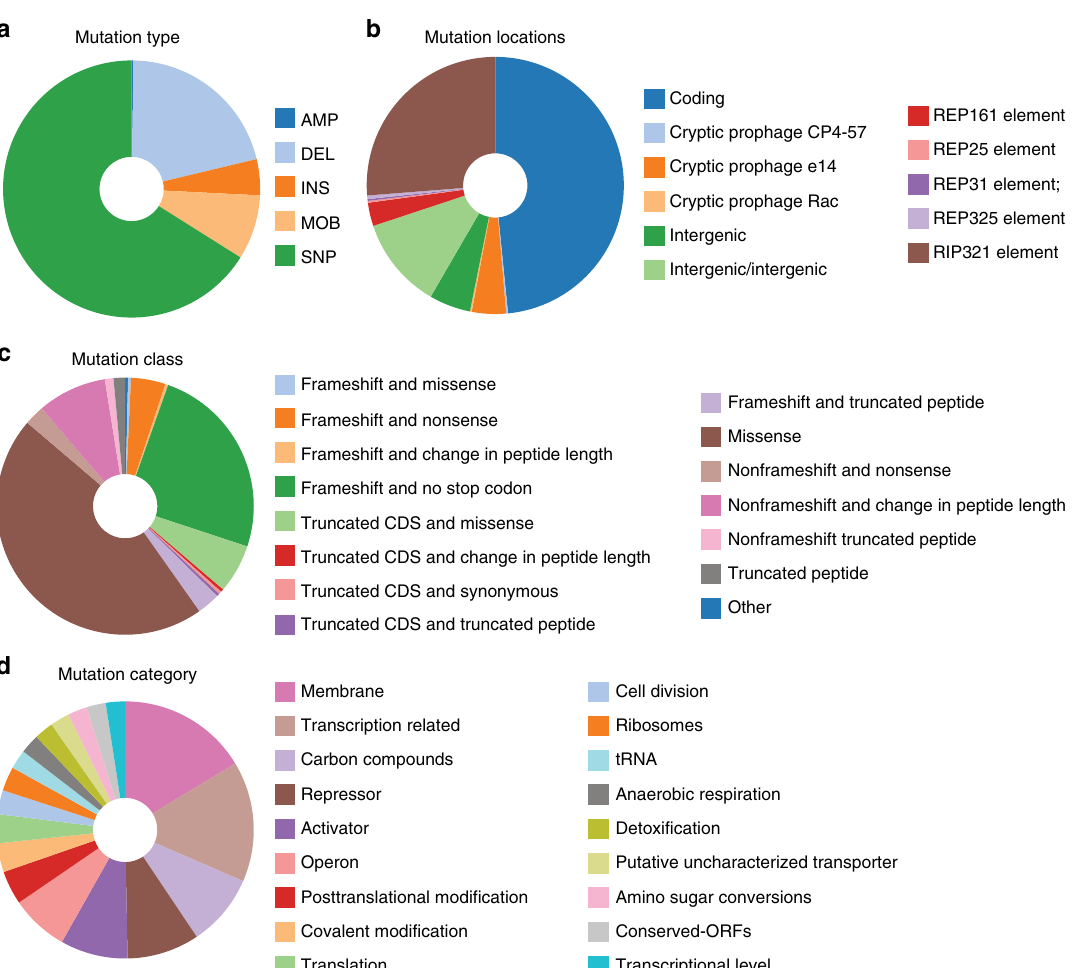
Fig. 6 Overview of mutation statistics. See Supplementary Data 6 for detailed statistics of each category and categories not shown. a The type of mutation. Mutations include ampli fi cation (AMP), deletion (DEL), insertions (INS), mobile element aided insertions or deletions (MOB), single nucleotide polymorphism (SNP). b The location of the mutation. Locations include coding regions, regions associated with cryptic prophages, intergenic regions, regions two coding genes not classi fi ed as an intergenic region (intergenic/intergenic), and repetitive elements (REP or RIP). c The class of mutation. Classes include frameshifts, frameshifts resulted in a truncated CDS, missense, non-frameshifts, peptide truncations, and other unclassi fi ed mutations. d The functional or structural category of the mutated gene. Categories are based on the “ parent class ” as found in the EcoCyc database